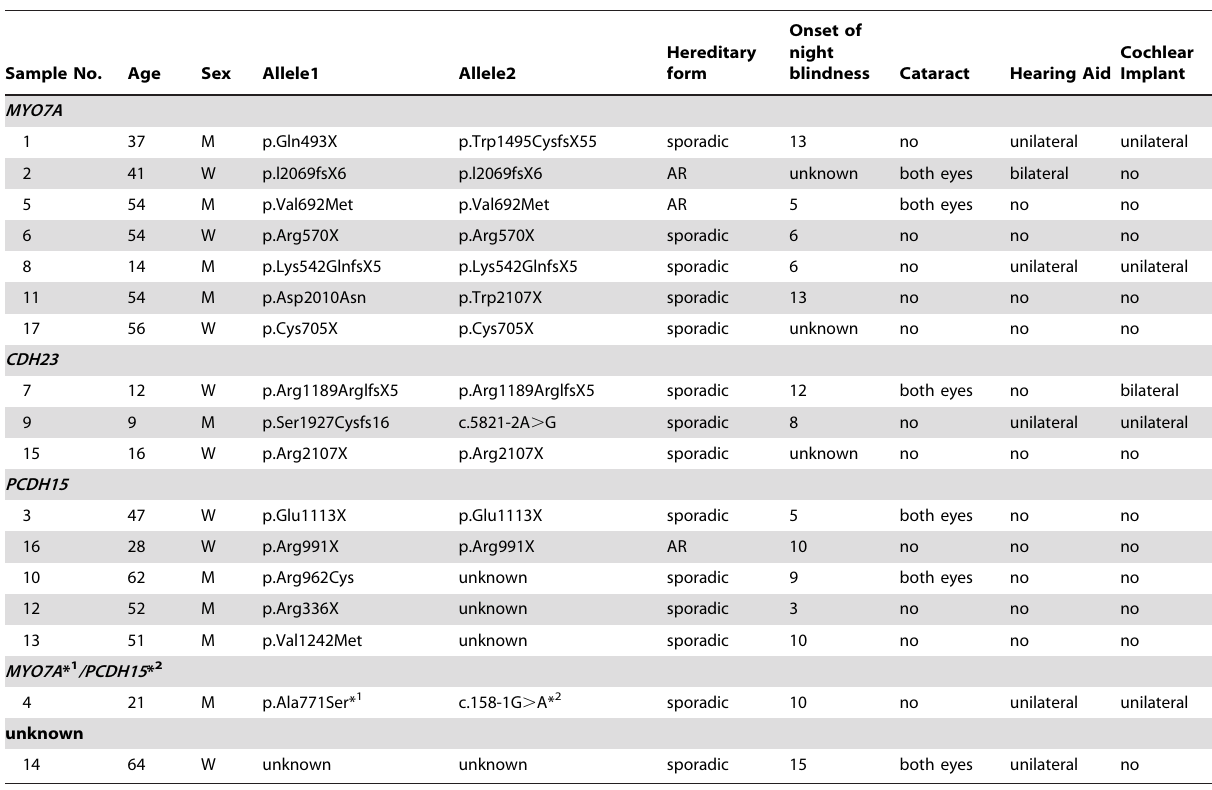
Table 2. Details of phenotype and genotype of 17 USH1 patients.